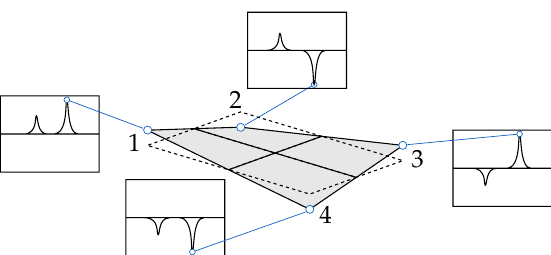
Figure 10. Display of a mode shape with associated parts of the power spectral densities (PSDs) for every extraction point.